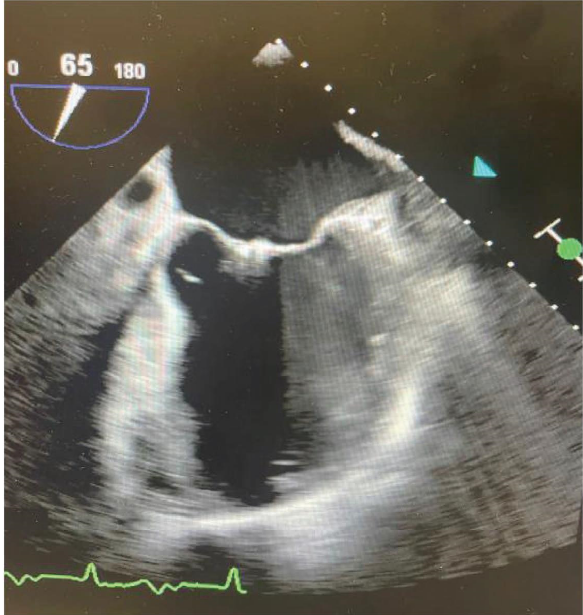
Figure 8: TEE of aortic valve vegetation